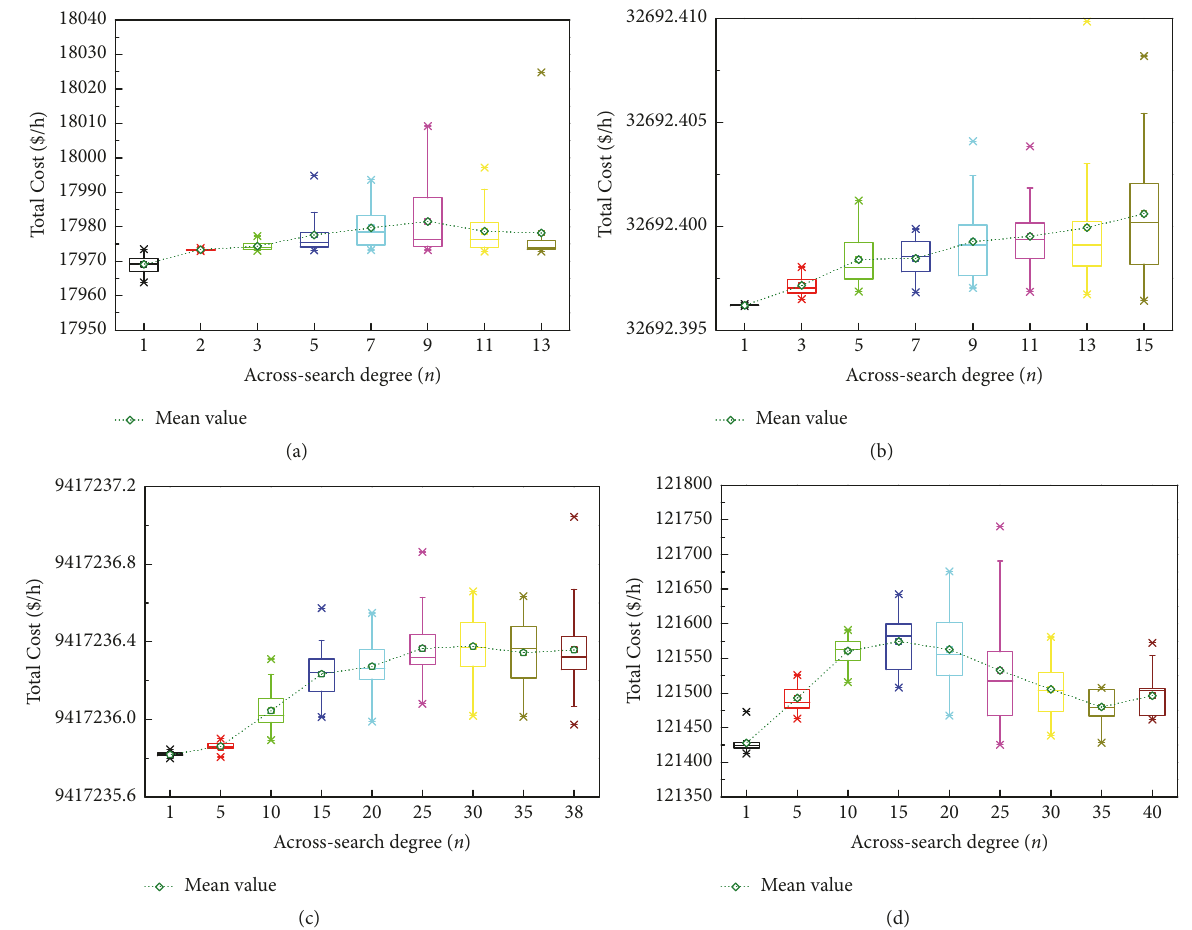
Figure 7: Influence of across-search degree. (a) Case I. (b) Case II. (c) Case III. (d) Case IV.